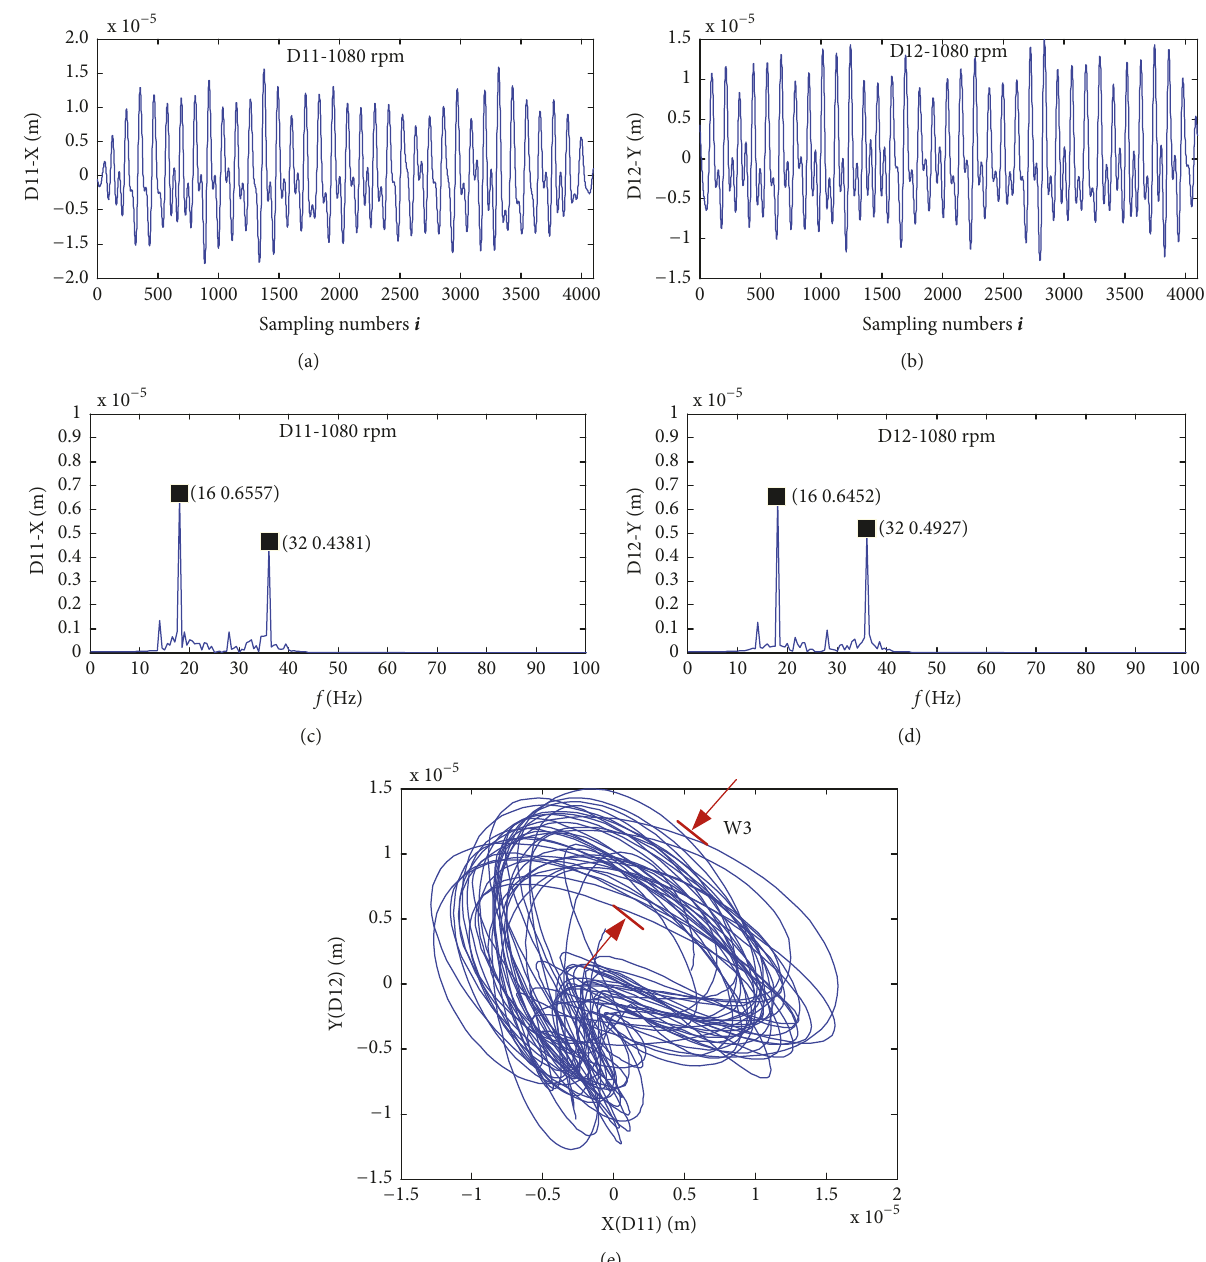
Figure 21: The purification effect of wavelet packet. (a) The time domain of D11. (b) The time domain of D12. (c) The frequency spectrum of D11. (d) The frequency spectrum of D12. (e) The orbit is to extract the first 2